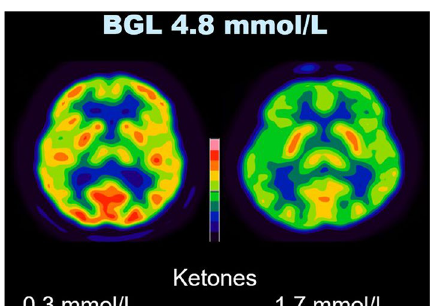
Fig. 2 Effect of serum ketone level on cerebral SUVbw. Sample images of two patients thresholded identically with the same BGL, but different serum ketone levels illustrate the reduction in FDG uptake in the brain seen with a higher serum ketone level